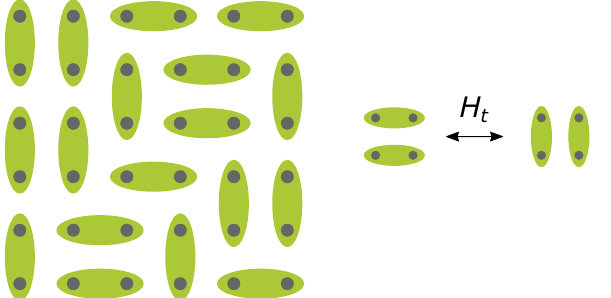
Figure 25: Fully packed QDM. Each site is dimerized with one of its nearest neigh- bors. Two parallel nearest neighbor dimers can flip, as shown on the